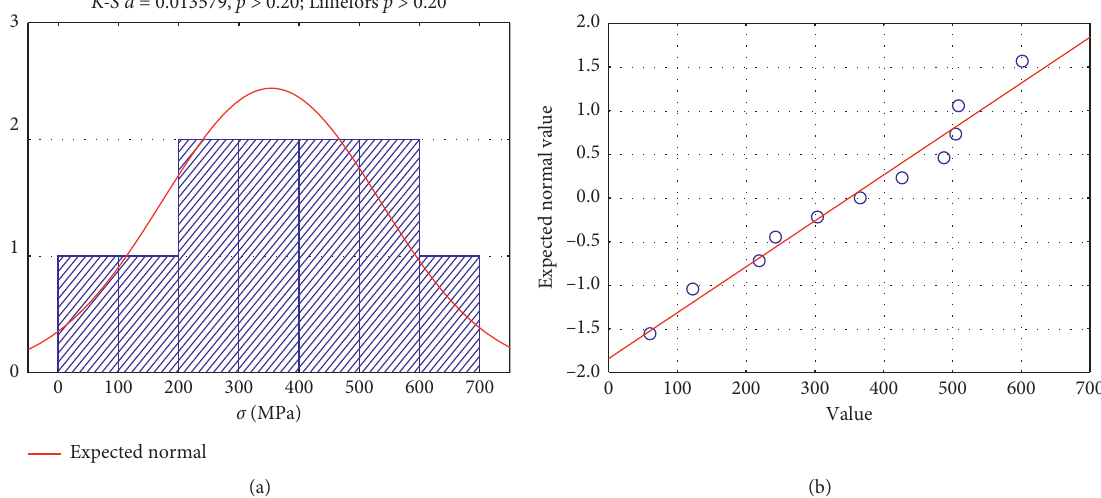
Figure 5: The distribution histogram of the stress experimental values with the superimposed curve of the expected normal distribution (a) and the graph of the normal distribution (b) for the deposited samples of group I.